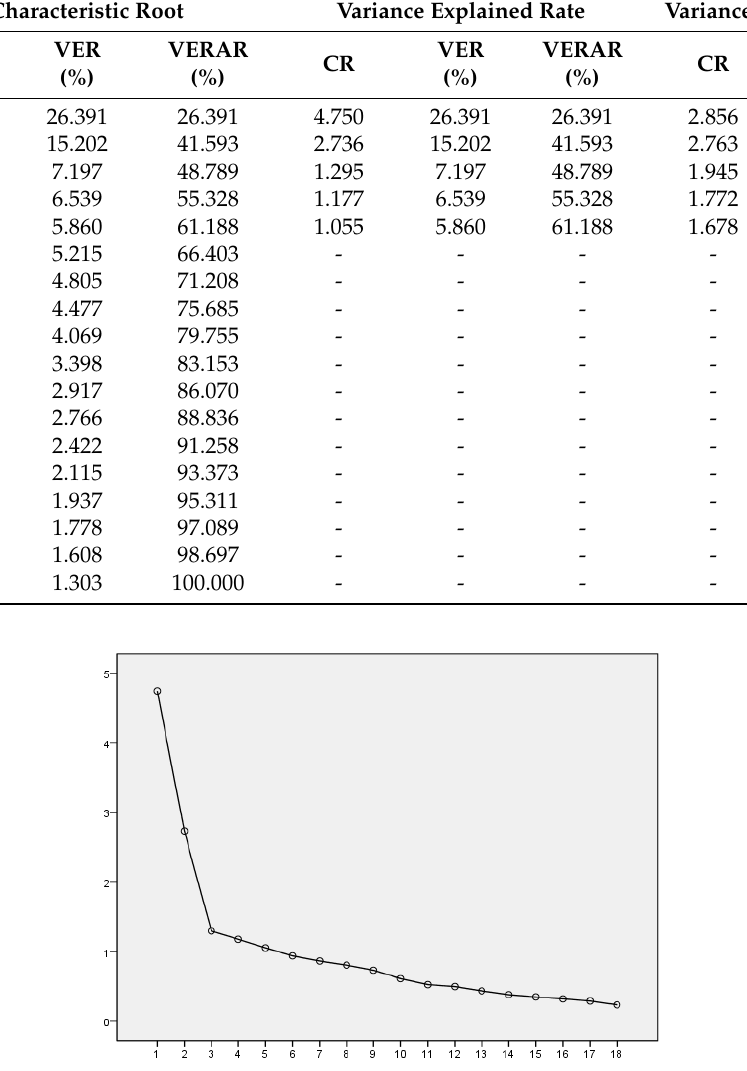
Figure 1. Gravel plot from exploratory factor analysis